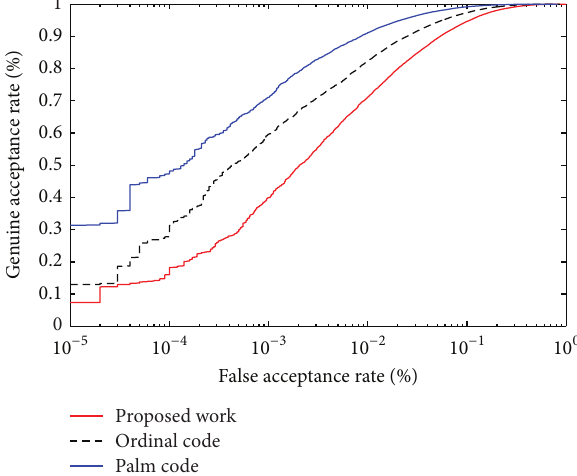
Figure 12: ROC curve using global features of proposed DOST for PolyU palmprint database.